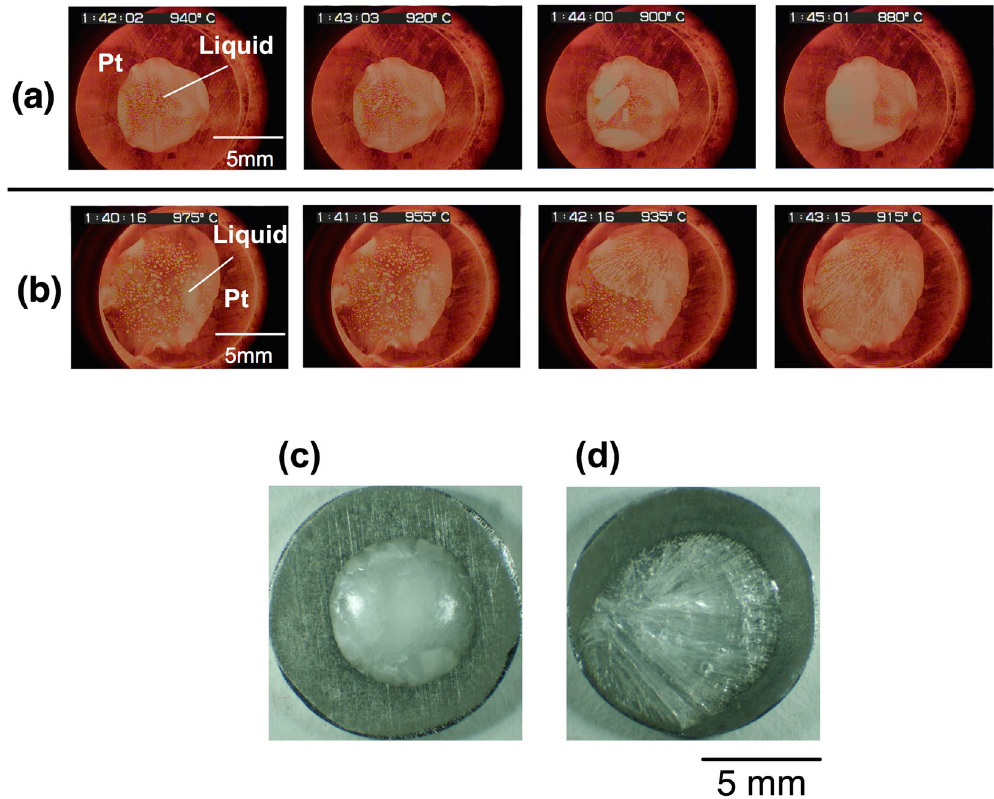
Figure 1. Crystallization behavior (top view) of supercooled liquid composed of lithium disilicate cooled from 1473 K at 20 K/min under ( a ) Ar ( P O2 ≈ 10 − 5 atm) as an example of Type Ι crystallization, and ( b ) under dry–air ( P O2 = 0.2 atm) as an example of Type ΙΙ crystallization. The temperature values on the images represent the temperatures measured using a thermocouple located near the substrate. Images of cooled samples ( c ) under Ar atmosphere with Type Ι crystallization, and ( d ) under dry–air with Type ΙΙ